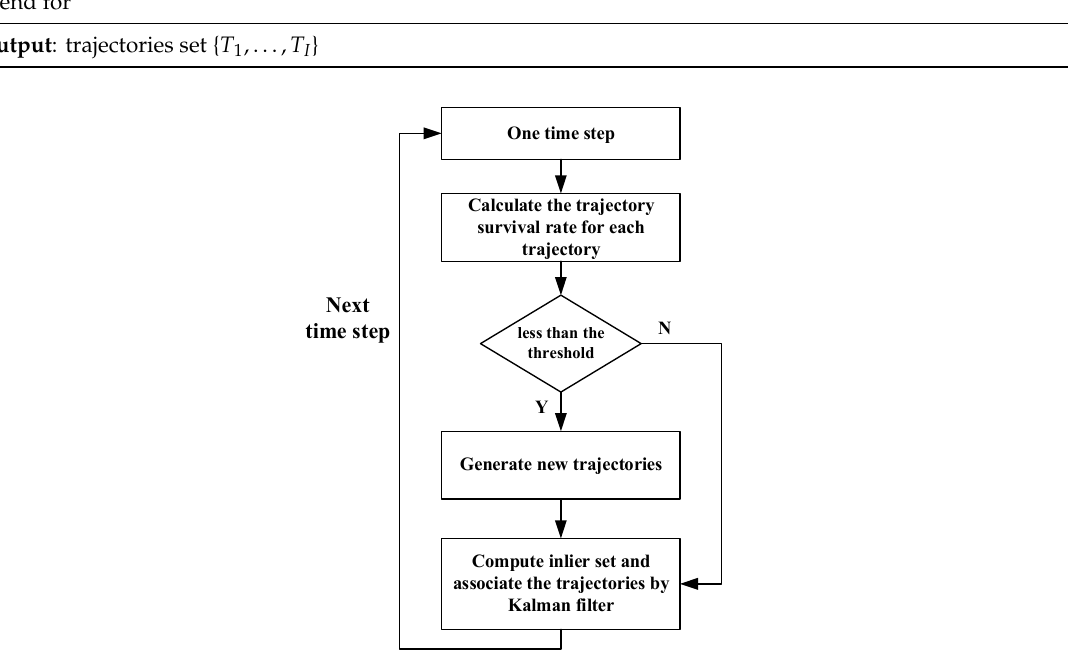
Figure 3. The flowchart of the modified Kalman filter (MKF) algorithm. Algorithm 1. The MKF Algorithm.